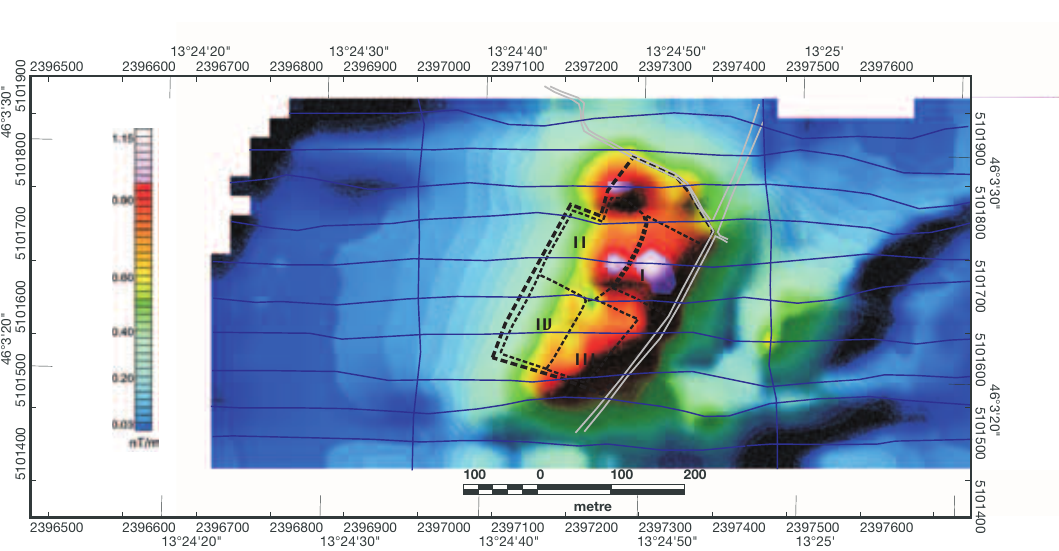
Fig. 6. Three-dimensional analytic signal map in the waste site area. Note contrasting signatures over different parts of the waste site.